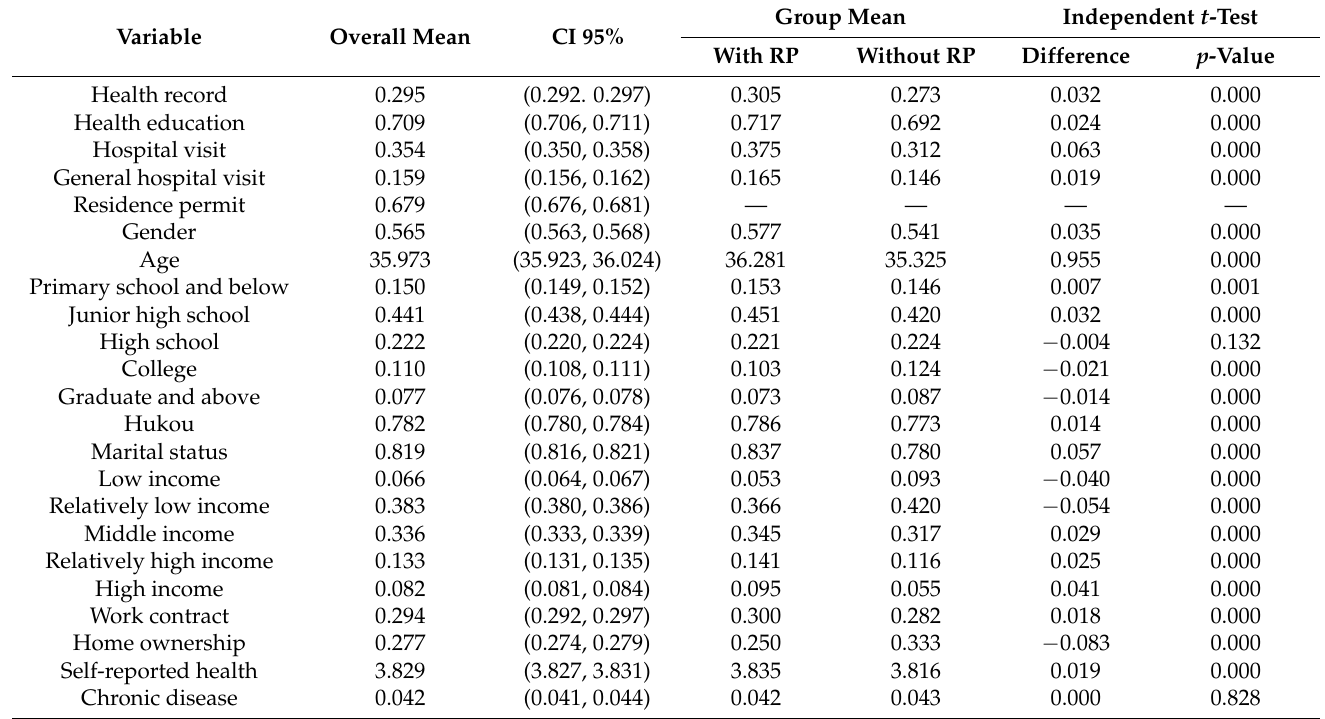
Table 1. Descriptive statistics of